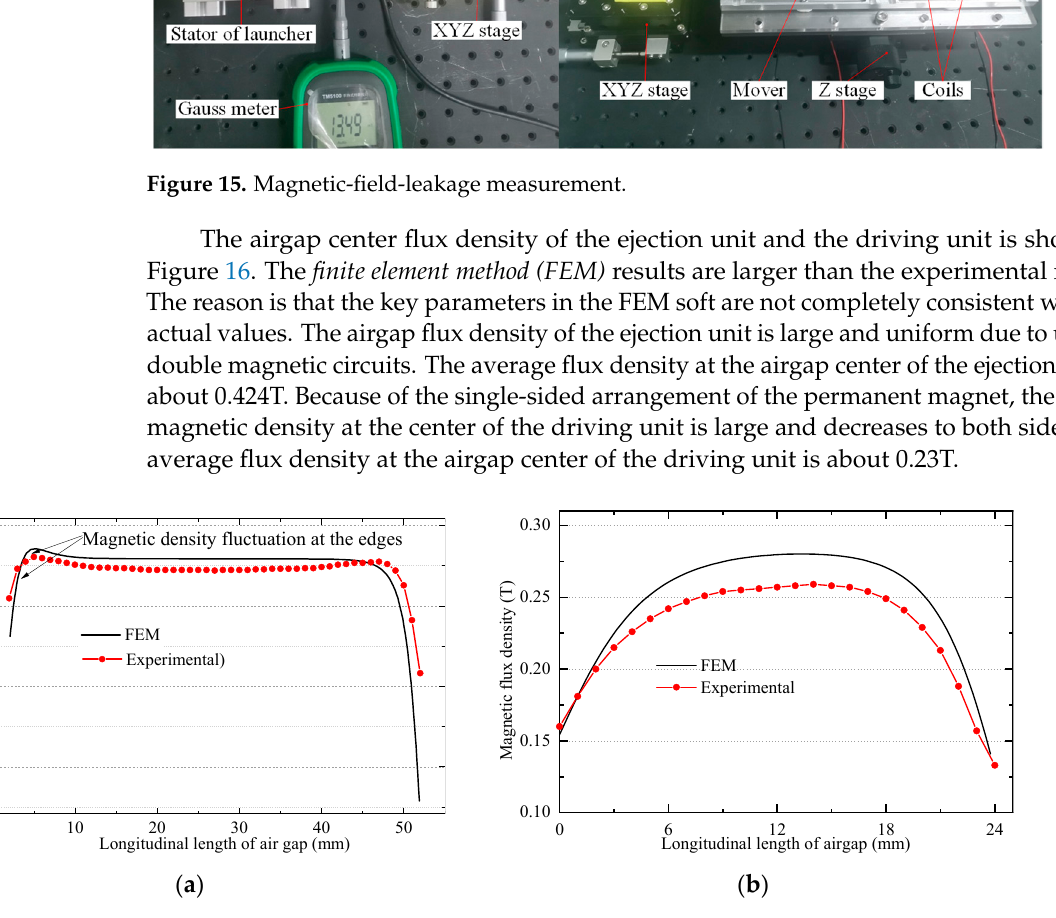
Figure 16. Magnetic field in the airgap center: ( a ) ejection unit and ( b ) driving unit. To evaluate the influence of magnetic field distribution on the CubeSat. Figure 17 illustrates magnetic field leakage at the key position close to the CubeSat. Due to the magnetic field enhancement of the double magnetic circuit, the magnetic flux leakage of the launcher is larger than that of the conveying platform. The magnetic field decreases from the center of the launcher to the edge region, as shown in Figure 17a. Due to the mutual superposition of the flux density leakage of the four ejection units, the magnetic field at the axis position of the launcher is the largest, at 20.17 mT. The flux density close to the edge position is the weakest, at the 5.2 mT. Figure 17b shows that the central region of the mover is the weakest, at 0.56 mT. The flux density leakage at the center region of the driving unit is about 1.41 mT. The maximum leakage magnetic density of the mover is about 1.62 mT. The measurement results show that the magnetic flux density leakage of the launcher and the conveying platform is small and does not damage the normal operation of the CubeSats.